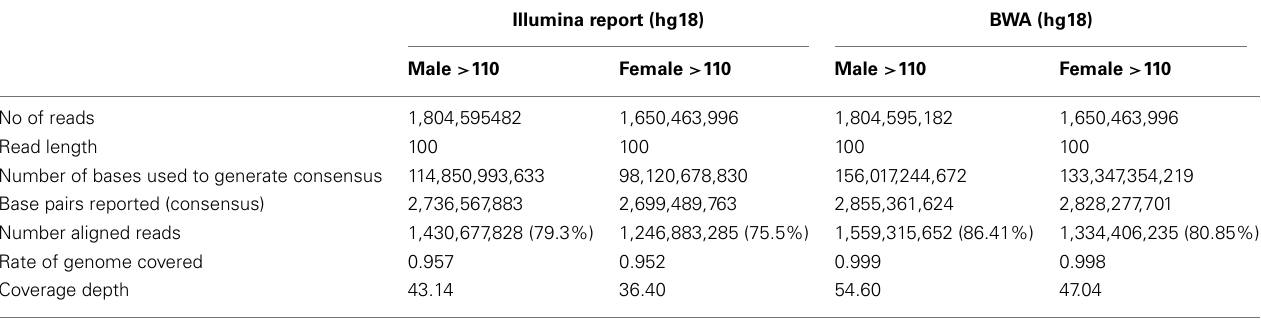
TableA1 | Summary of sequencing and mapping using the Illumina aligner and the BWA